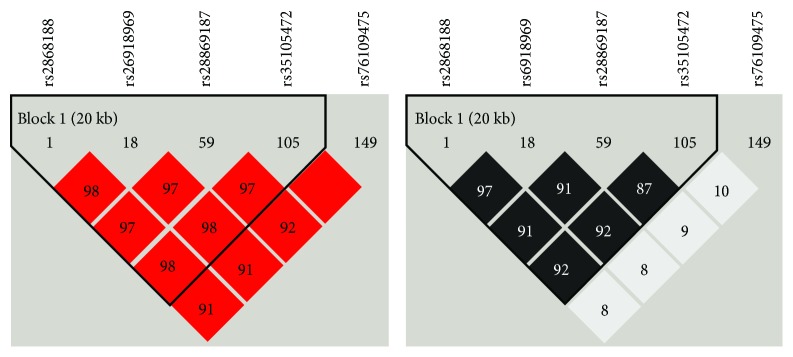
Linkage disequilibrium (LD) plots for SNPs genotyped in the NF-YA region, which were generated by Haploview 4.2 software. SNPs are identified by their rs number in dbSNP. Red shades (left) show the strength of the pairwise LD based on D′ expressed as a percentile within squares. Black shades (right) demonstrate the strength of the pairwise LD based on r
2, and the number is the r
2 value expressed as a percentage.